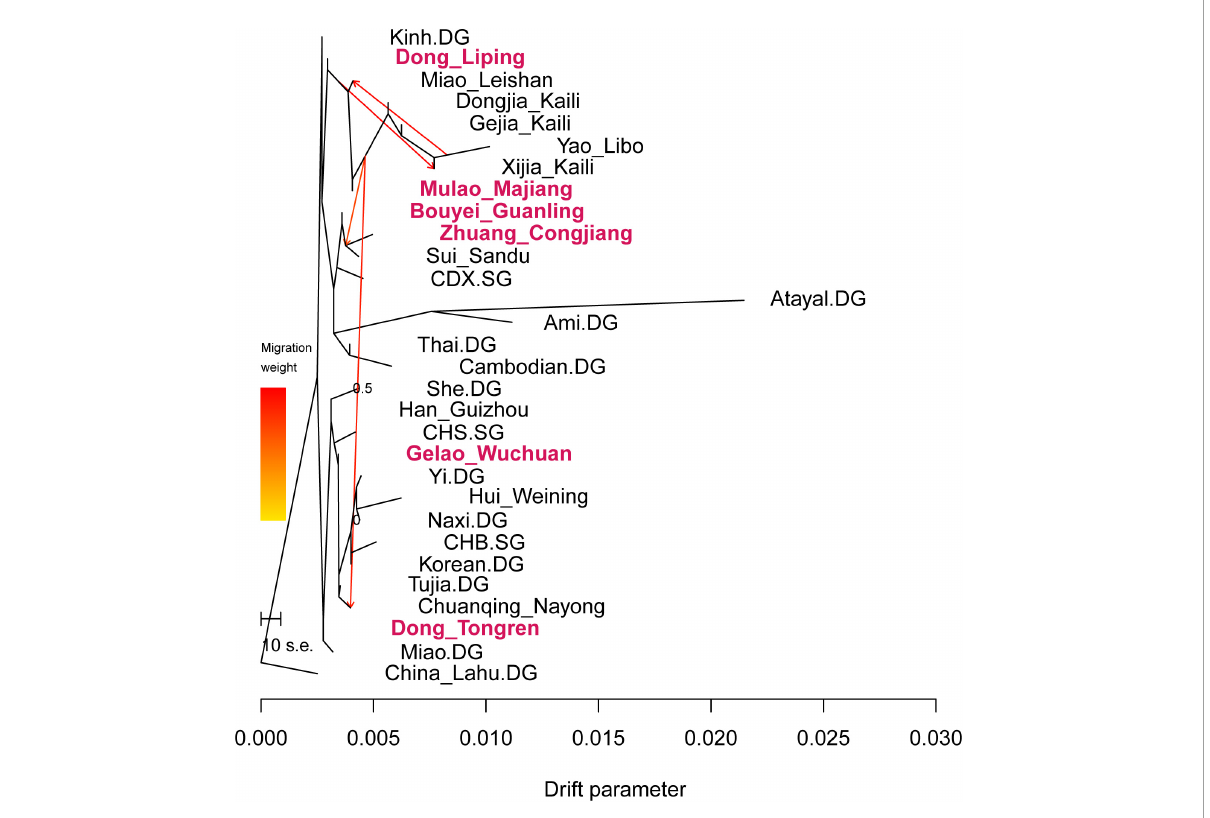
FIGURE5 Genetic splits and admixture pattern of Guizhou Tai-Kadai-speaking and reference